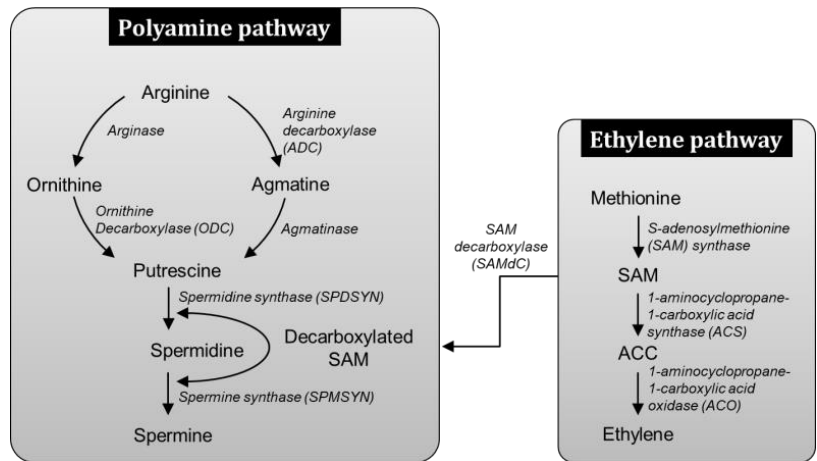
Figure 1. Polyamine biosynthesis pathway and its linkage to ethylene biosynthesis pathway. S-adenosylmethionine (SAM) is a precursor for ethylene biosynthesis which is synthesized from methionine by SAM synthase. The generated SAM is then converted to ethylene by the action of 1-aminocyclopropane-1-carboxylic acid synthase and 1-aminocyclopropane-1-carboxylic acid oxidase enzymes. SAM also gets decarboxylated upon SAM decarboxylase (SAMdC) action and can act as precursor for spermidine and spermine synthesis. Putrescine can be directly synthesized from ornithine by the action of ornithine decarboxylase or indirectly from arginine by arginine decarboxylase.